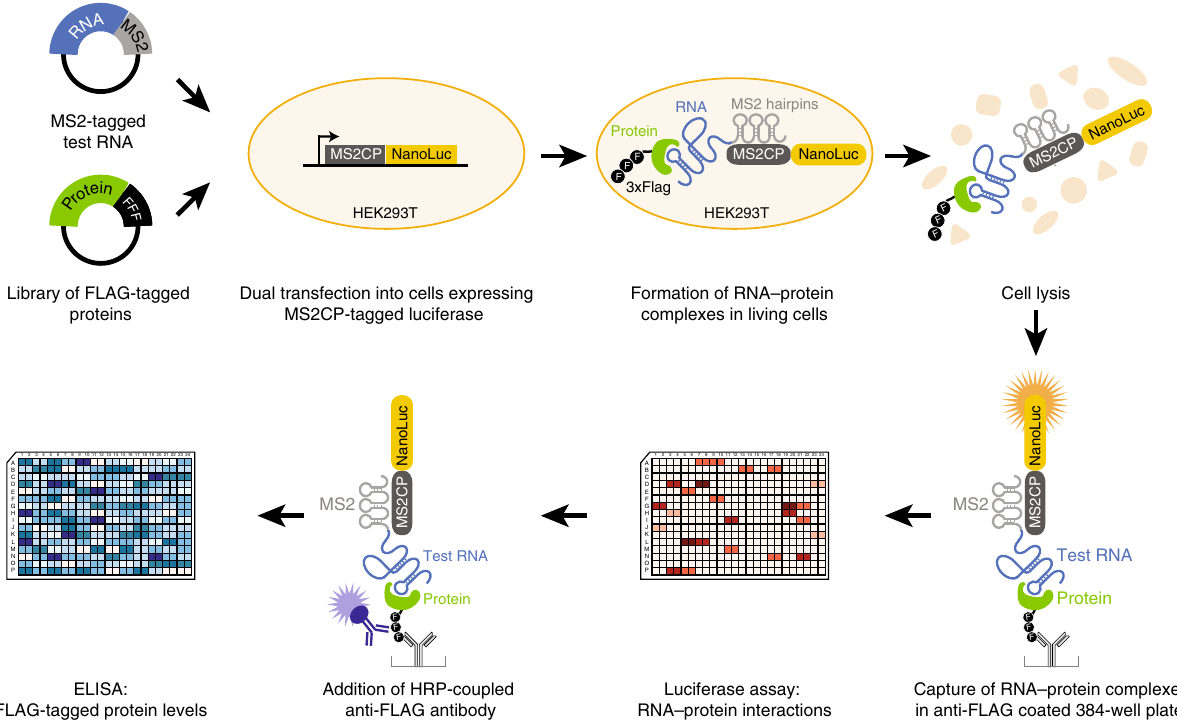
Fig. 1 Principle of the incPRINT method. HEK293T cells, stably expressing a NanoLuc luciferase-MS2CP recombinant protein from an integrated plasmid, were co-transfected with plasmids encoding a MS2-tagged test RNA and 3xFLAG-tagged test proteins in a 96-well format (each well contains cells expressing one tagged test RNA and one tagged test protein). Cell lysates were applied to anti-FLAG-coated 384-well plates to immuno-purify test proteins with their interacting RNAs. After washing off nonspeci fi c interactions, the MS2-RNA/FLAG-tagged protein complexes were detected by NanoLuc luciferase, tethered to the test RNA through the MS2-MS2CP interaction. The expression levels of the FLAG-tagged test proteins were detected by ELISA using a second anti-FLAG antibody coupled to horseradish peroxidase